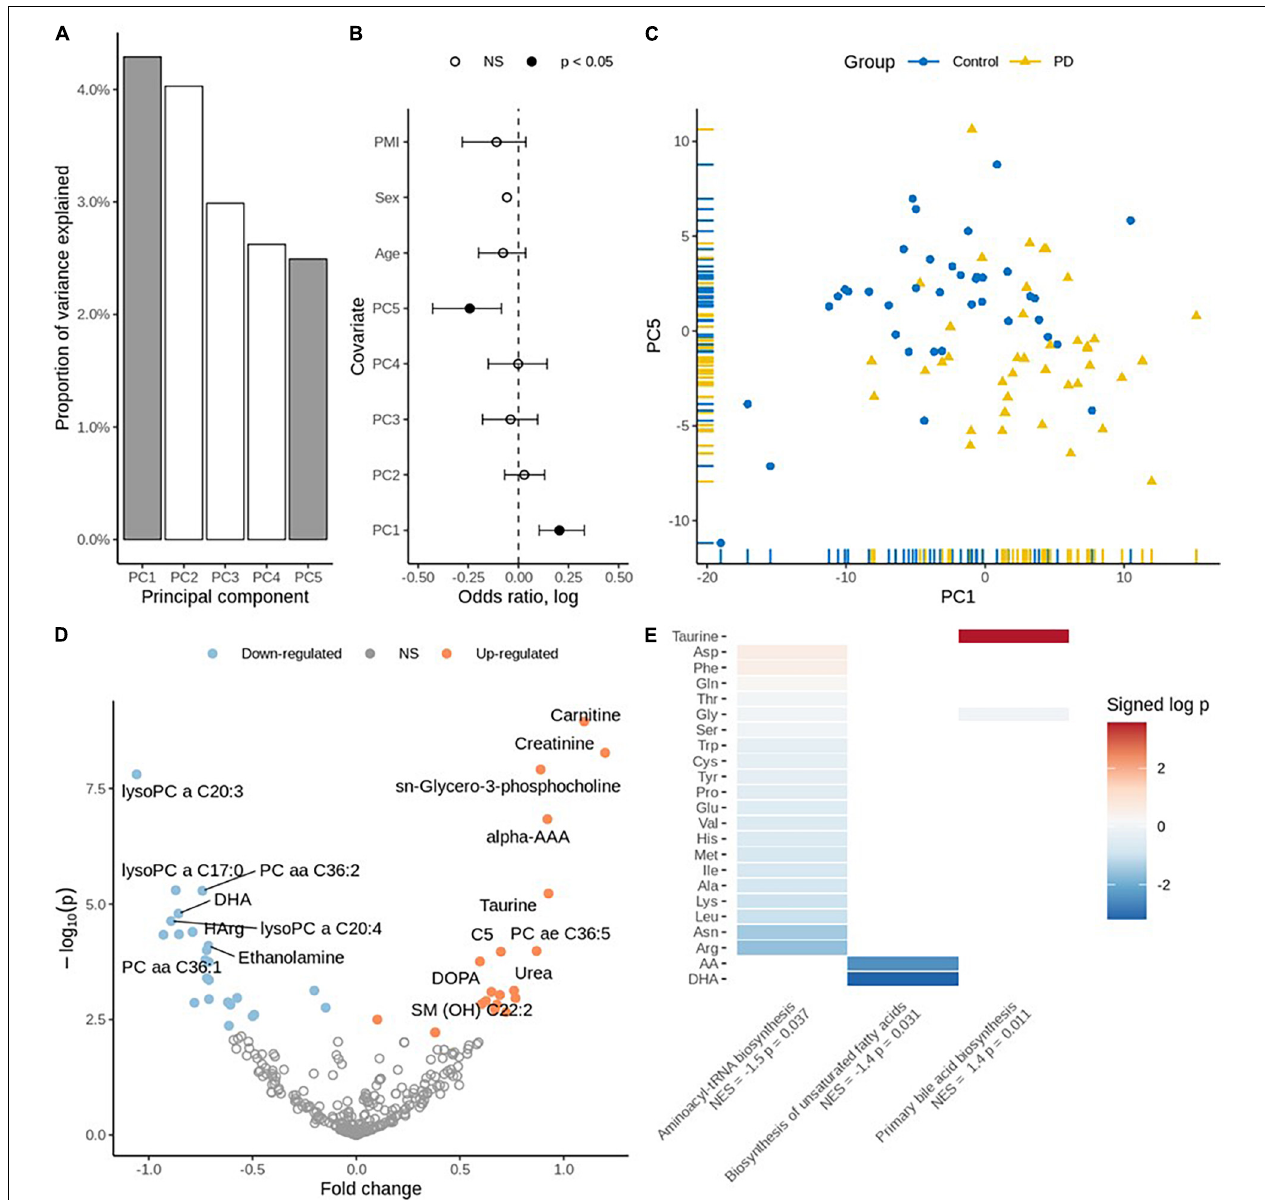
FIGURE 1 | (A) Principal component variance: the highlighted two components (PC1 and PC5) were associated with the diagnosis of PD. (B) Association of principal components with the diagnosis: binomial regression with five principal components, age, sex, and PMI as covariates. (C) Scatter plot displaying PC1 vs. PC5. (D) Volcano plot for individual metabolites: Up-regulated metabolites are coded using orange and down-regulated are coded using blue color. (E) Enriched pathways of metabolites: Taurine is significantly perturbed on “Primary bile acid biosynthesis,” DHA and Arachidonic acid are significantly perturbed on “Biosynthesis of unsaturated fatty acids”. The other metabolites provided on plot are perturbed to be significant on Aminoacyl t -RNA biosynthesis. Normalized Enrichment Score (NES) and the significance ( p -values) are